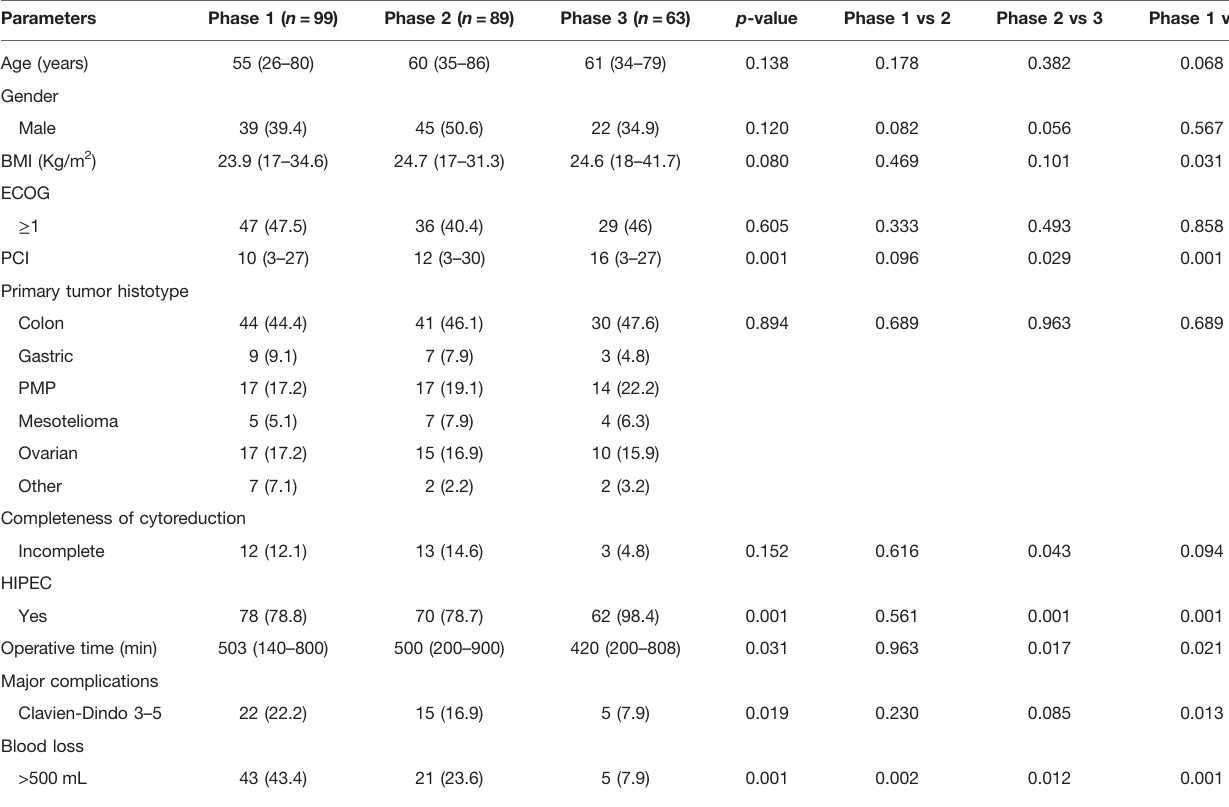
TABLE 3 | Comparison of baseline characteristics and perioperative outcomes among the three phases de fi ned by the RA-CUSUM analysis.